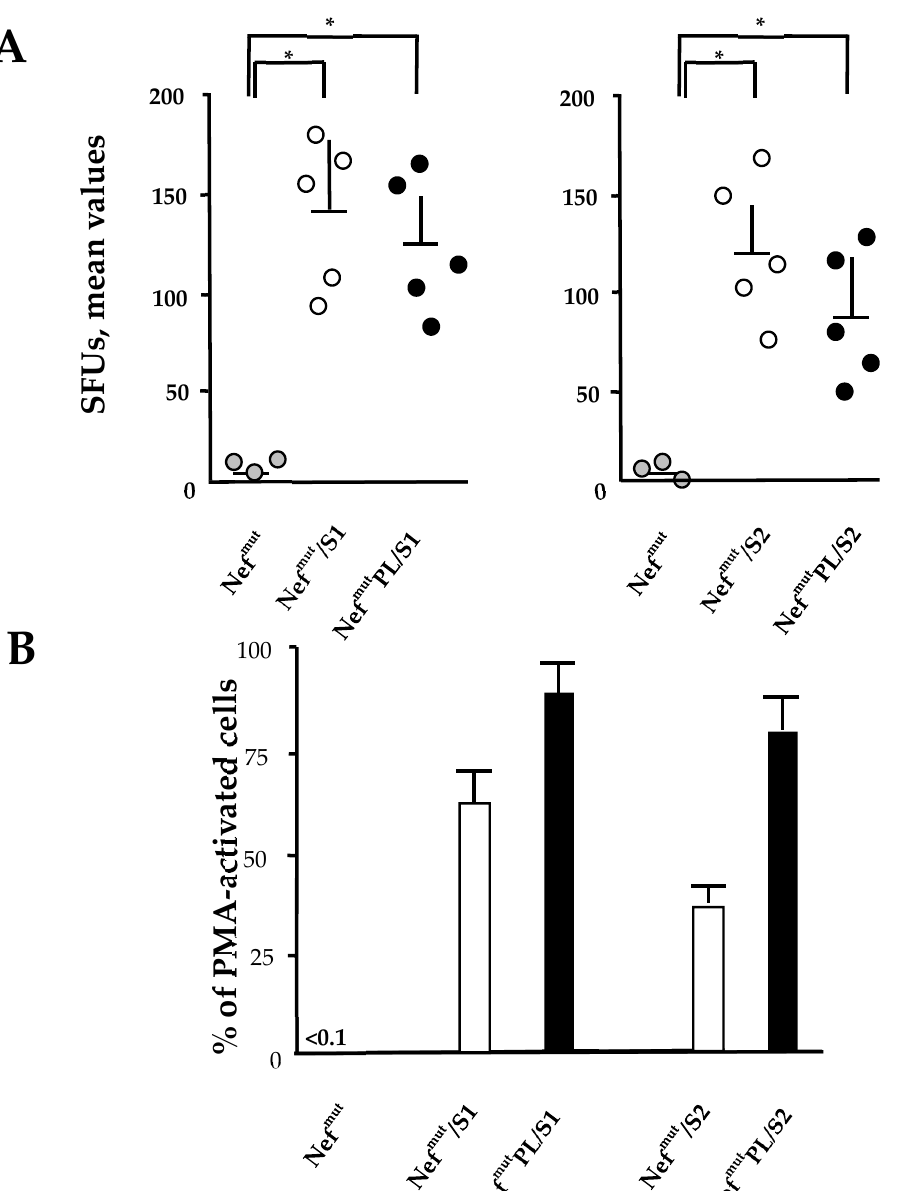
Figure 6. SARS-CoV-2-specific CD8 + T cell immunity induced in both spleens and lungs of DNA injected mice. ( A ). CD8 + T cell immune response in either C57 Bl/6 (for S1-expressing vector) or Balb/c (for S2-expressing vector) mice inoculated i.m. with DNA vectors expressing either Nef mut or Nef mut PL fused with the indicated SARS-CoV-2 antigens. As controls, mice were inoculated with a vector expressing Nef mut . At the time of sacrifice, 2.5 × 10 5 splenocytes were incubated ON with or without 5 µ g/mL of either unrelated or SARS-CoV-2-specific peptides in triplicate IFN- γ EliSpot microwells. Shown are the numbers of IFN- γ SFUs/well as mean values of triplicates after subtraction of mean values measured in wells seeded with splenocytes treated with unspecific peptides. Intragroup mean values + SD are also shown. The results are representative of two independent experiments. Statistical significance compared to values obtained with splenocytes injected with Nef mut expressing vectors was determined by the Mann-Whitney U test. * p < 0.05. ( B ). Percentages of SFUs+SD detected in IFN- γ EliSpot microwells seeded with 10 5 cells from pooled BALFs in the presence of SARS-CoV-2-specific peptides compared to PMA plus ionomycin, which generated from 100 to 300 SFUs. Cell samples seeded with unrelated peptides scored at background levels (not shown). The results are representative of four independent